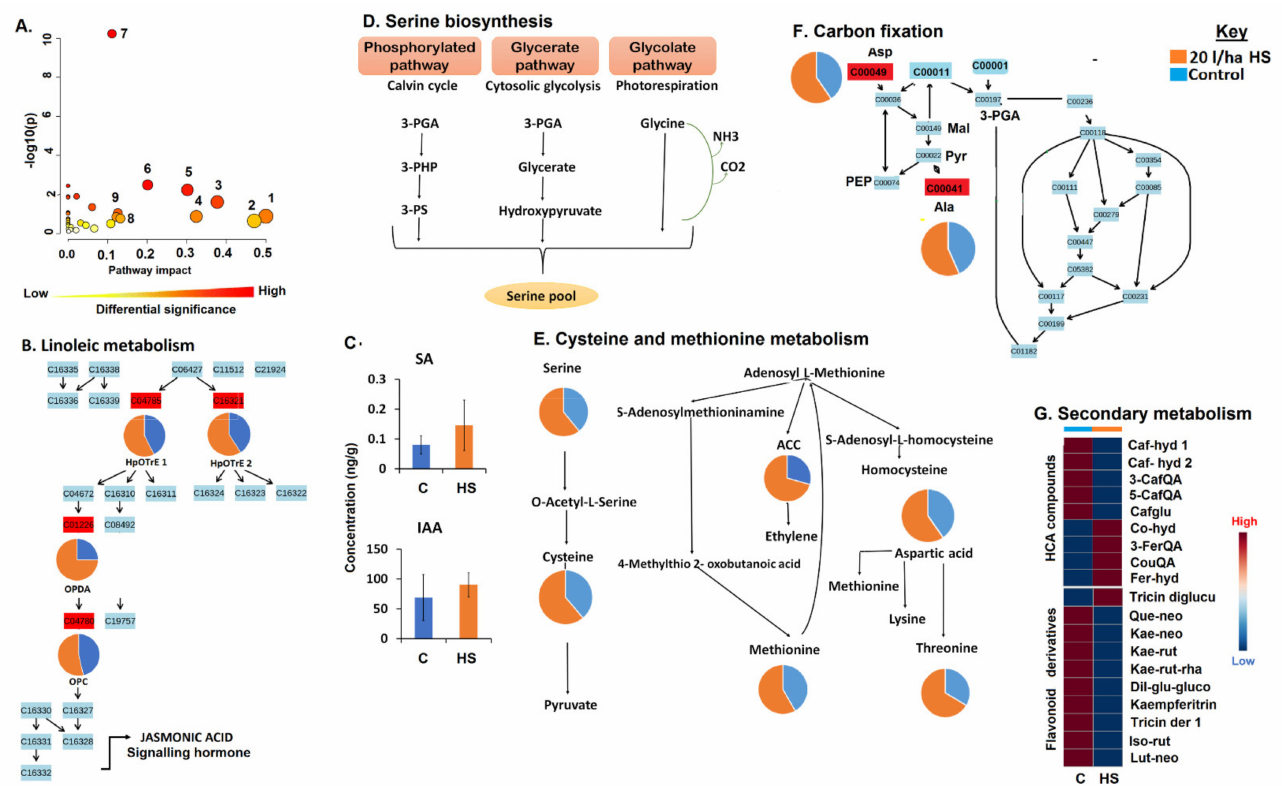
Figure 2. A summary of metabolic pathway analysis generated using MetPA, pathway mapping and relative quantification of some altered amino acid, hormones, oxylipins and phenolic compounds. ( A ) The graph displaying the ‘metabolome view’ containing all the mapped pathways arranged by p -values on the y -axis and the pathway impact (differential significance) on the x -axis. (1) Isoquinoline alkaloid biosynthesis, (2) phenylalanine metabolism, (3) alpha-linolenic acid metabolism, (4) tryptophan metabolism, (5) glycine, serine and threonine metabolism, (6) cysteine and methionine metabolism, (7) aminoacyl-tRNA biosynthesis, (8) stilbenoid, diarylheptanoid and gingerol biosynthesis (9), refer to Table S1. ( B ) Linoleic metabolism. ( C ) Absolute quantification of selected hormones. ( D ) Serine biosynthesis. ( E ) Cysteine and methionine metabolism. ( F ) Carbon fixation in photosynthetic organisms. ( G ) Secondary metabolism, relative quantification of selected phenolics. Abbreviation: 3-PGA, 3-phosphoglyceric acid; 3-PHP,